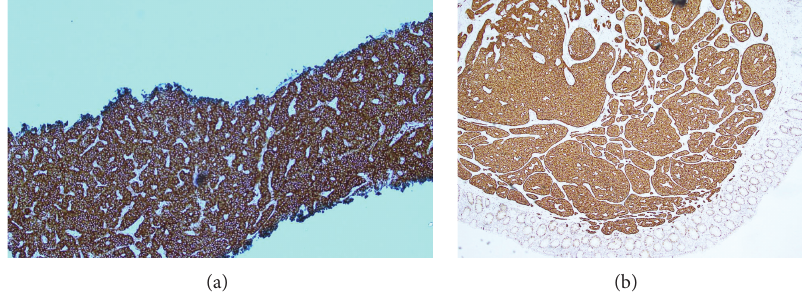
Figure2:Biopsyspecimensfromlung(a)andrectalpolyp(b).(a)Histologicalanalysisoflunglesionrevealedcolumnarcellswithblandnuclei arranged in an insular pattern with infrequent mitoses. Staining for neuron-specific enolase, synaptophysin, and CD56 was highly positive, but negative for chromogranin A and S100, suggestive of typical carcinoid neoplasia. (b) Rectal polyp analysis showed well circumscribed growth of uniform polygonal cells with round nonmitotic nuclei and speckled chromatin with nested and acinar growth pattern; features indicative of a benign endocrine tumour. Histologically, the specimen from the rectum was not suggestive as being related to the lung lesion, hence the labelling of this case as